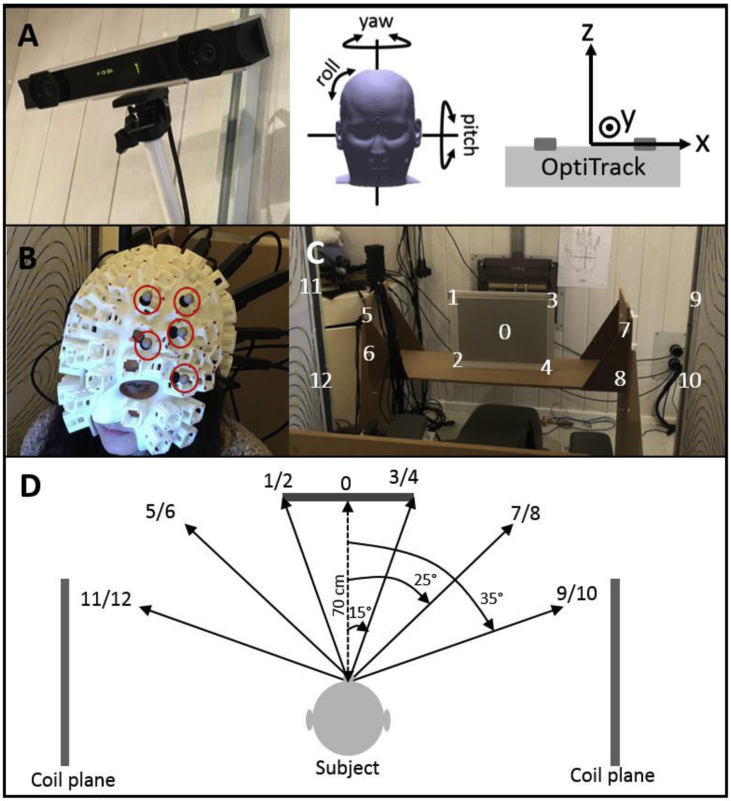
A) The OptiTrack V120:Duo optical tracking camera is used to measure subject movement. The translations (x, y, z) and rotations (pitch, yaw, roll) are measured in the camera's frame of reference. B) The system uses infra-red LEDs to illuminate a series of 5 highly reflective markers (circled in red) positioned on the surface of the scanner-cast. These markers are combined to form a single rigid-body which is then tracked during an experiment. C) A series of 13 numbered marks were positioned within the field of view of the subject. The subject was instructed to shift their gaze to these marks. D) Approximate angular movements of the head required to shift the gaze to each mark.